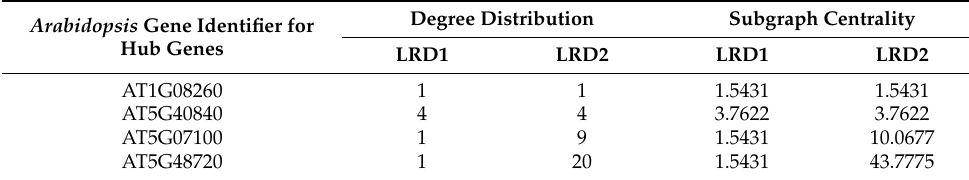
Table 3. Network measures for hub genes in the subnetworks for the cellular response to stress process under low radiation dose.